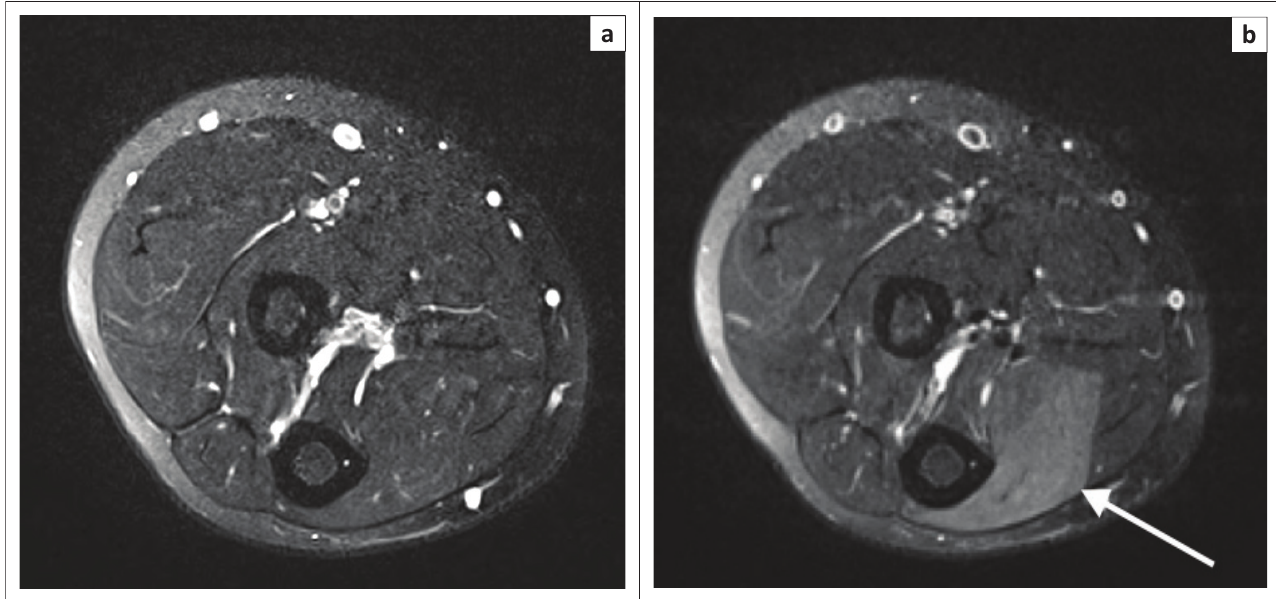
FIGURE 3: (a) Axial fat-suppressed T2-weighted magnetic resonance imaging of the right forearm , pre-exercise demonstrates iso-intensity of muscle groups. Note the normal calibre of intramuscular vessels; (b) Axial fat-suppressed T2-weighted magnetic resonance imaging of the right forearm, post-exercise – white arrow showing hyperintensity of the flexor digitorum profundus muscle and effaced intramuscular vessels.